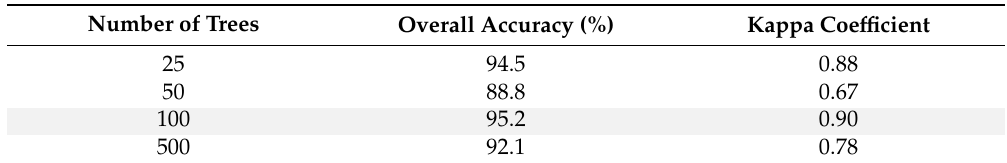
Table 2. Overall accuracy and Kappa coe ffi cient for national commodity maps produced by Random Forest classifier using di ff erent number of trees (N). Grey highlighted row represents the highest accuracy of five main commodity.